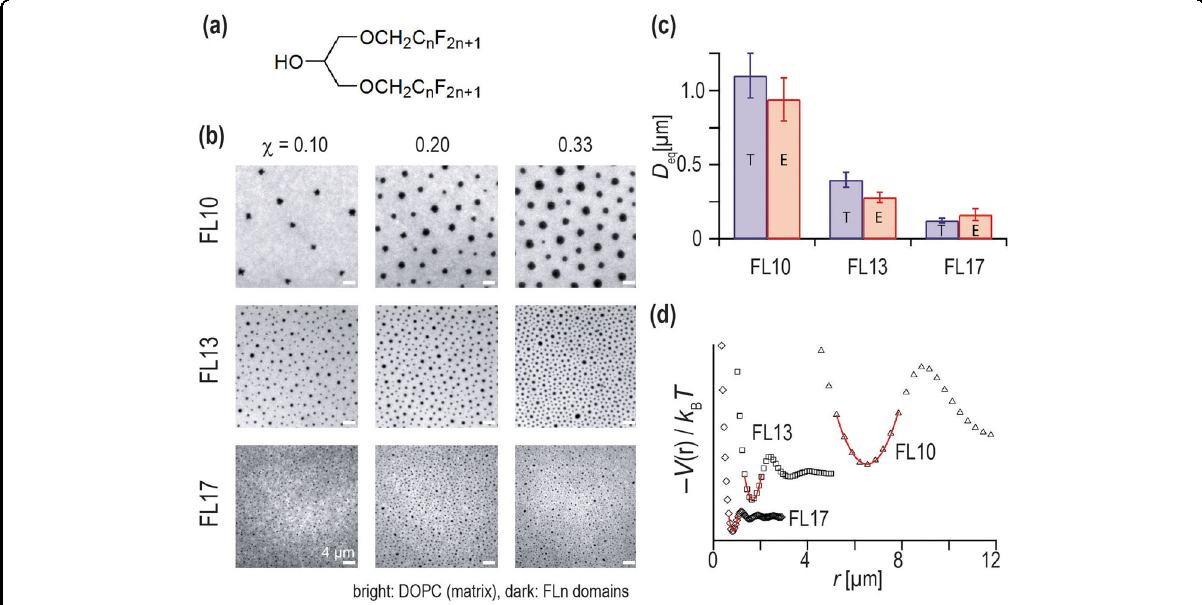
Fig. 4 Per fl uorinated lipid (FLn) achieves long-range order in a phospholipid membrane. a Chemical structure of FLn lipids ( n = 10, 13, 17). b Fluorescence microscopy images of FL10, FL13, and FL17 measured at π = 20 mN/m at molar fractions χ of 0.10, 0.20, and 0.33. The bright regions coincide with DOPC (matrix) lipids, while the dark regions are FLn domains. c Equilibrium domain sizes D eq calculated using the effective dipole model (T) and experimental data (E) for χ = 0.33. The size distributions (mean ± standard deviation) and the parameter errors used for the calculation are presented by the error bars. d Normalized potential of mean force – V ( r )/ k B T plotted against distance from the center of domain r . Adapted from refs. 69,70